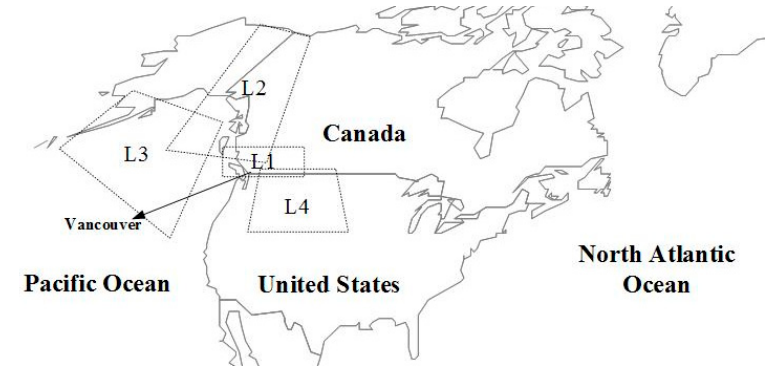
Figure 2. Location of the selected areas to obtain large scale climate signals for rainfall forecasting for Vancouver.